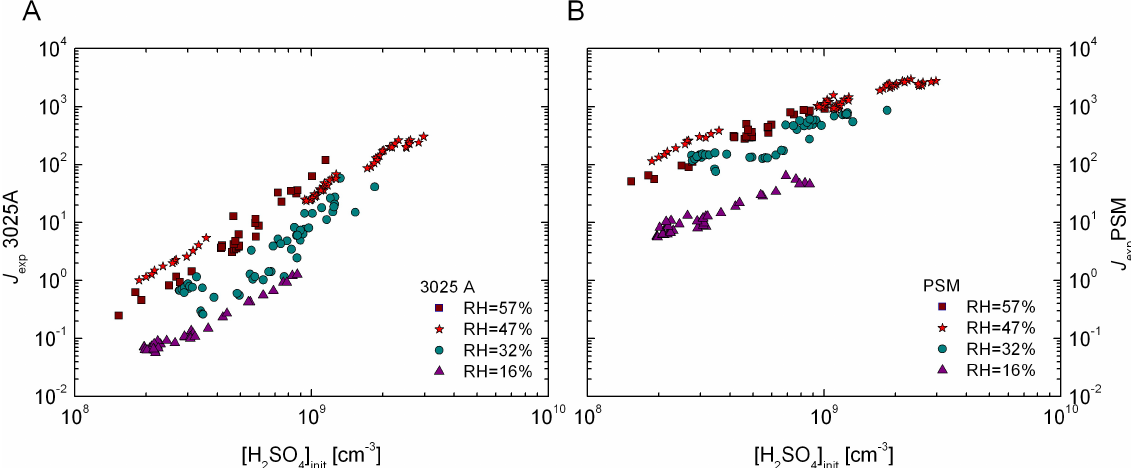
Fig. 1. Nucleation rates (cm − 3 s − 1 ) of sulfuric acid and water as a function of sulfuric acid initial concentration, nucleation temperature T=25 ◦ C. Particle number concentration measured with UCPC TSI 3025 A (A) and particle size magnifier (PSM) (B) .